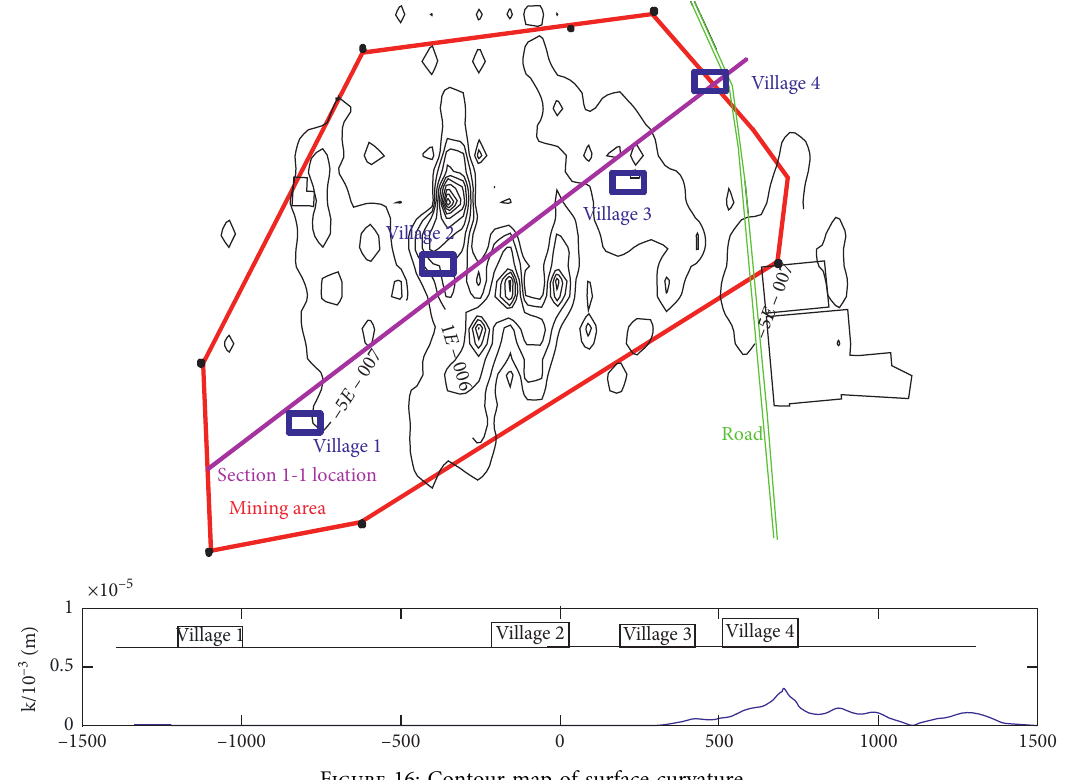
Figure 16: Contour map of surface curvature.